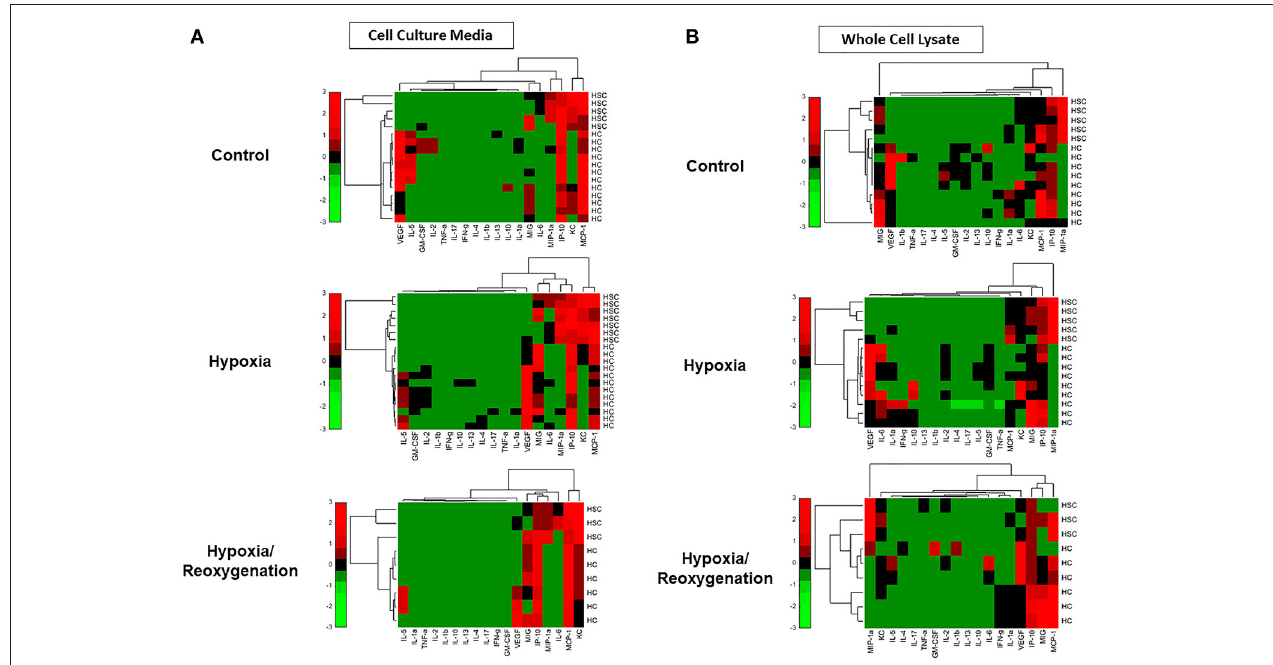
FIGURE 3 | Hierarchical clustering of inflammatory mediators in mouse hepatic stellate cells (HSC) and hepatocytes (HC) and Freshly isolated HSC and HC from C57BL/6 mice were cultured under 21% O 2 for 6h (control), hypoxia (1% O 2 ) for 6h or hypoxia (6h) followed by reoxygenation for 18h. Inflammatory mediators were measured by Luminex TM in both cell culture media (CCM) (A) and whole cell lysate (WCL) (B) as described in Materials and Methods. Fold change values for each inflammatory mediator are represented in heat maps, ranging from large negative (green) to large positive values (red). No changes (zero values) are represented in